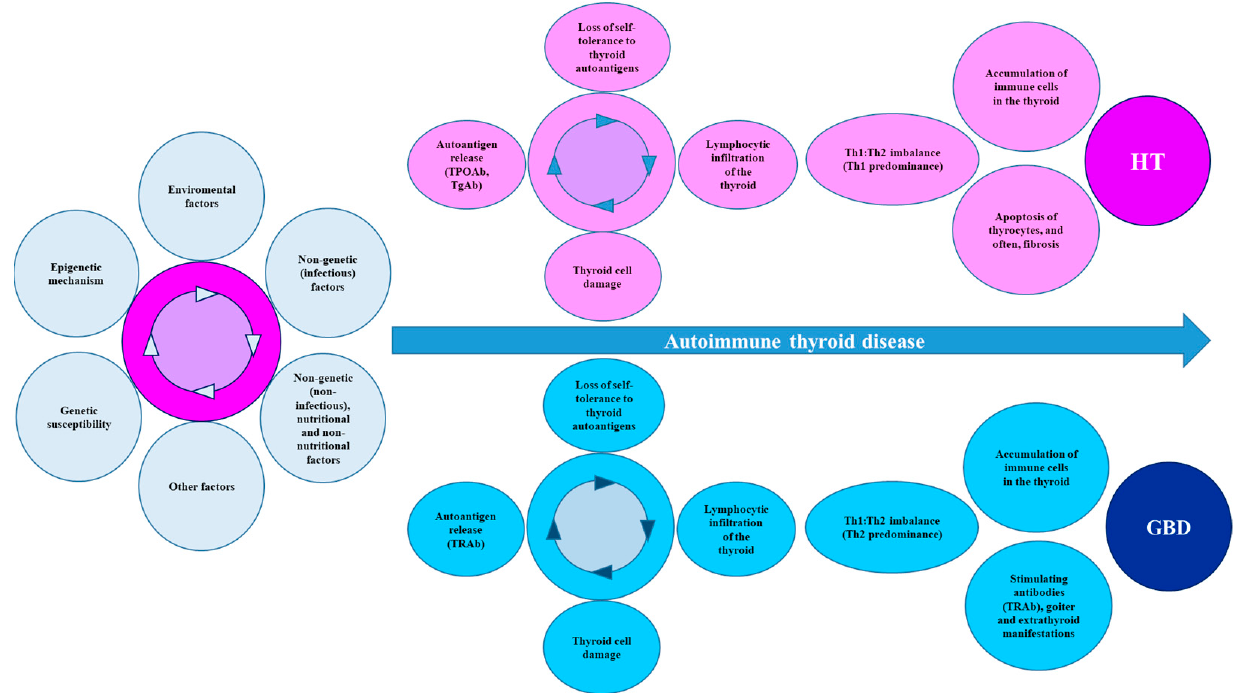
Figure 4. Summary of the mechanisms that lead to AITD. AITD is the product of multiple environ- mental factors that act on the basis of genetic susceptibility, together with some epigenetic mechanisms, leading to a loss of immune tolerance, with destruction of thyroid tissue and increased synthesis and secretion of autoantibodies. Finally, the Th1:Th2 imbalance directs the clinical